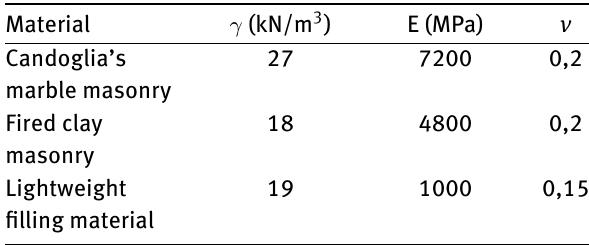
Table 5: Mechanical parameters of the materials